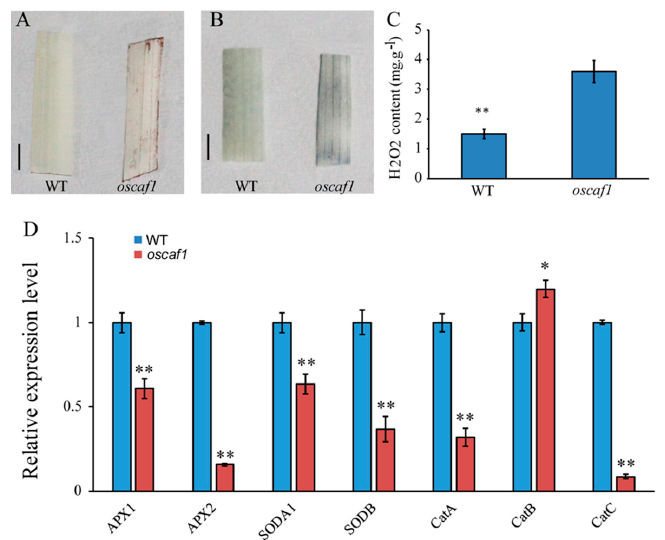
Figure 4. DAB, NBT staining, H 2 O 2 contents and gene expression level analysis in WT and oscaf1 mutants. ( A ) DAB staining of leaves from WT (left) and oscaf1 mutants (right). Scale bar, 1 cm. ( B ) NBT staining of leaves from WT (left) and oscaf1 mutants (right). Scale bar, 1 cm. ( C ) Measurement of H 2 O 2 content in WT and oscaf1 mutant ( D ) Relative expression levels of genes involved in ROS-scavenging. The data represent mean ± SE from three independent biological duplicate, * and ** indicated p < 0.05 and p < 0.01, respectively.